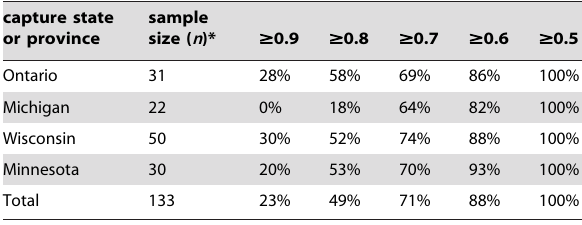
*stable isotope values from each monarch were re-sampled 100 times. Confidence in assignments represent the proportion of 100 re-samples for each monarch that were estimated to have originated from the same region based on subsequent assignments. The percentage of monarchs that are assigned to a breeding region with a given confidence ( . 0.5– . 0.9) is shown for each state/